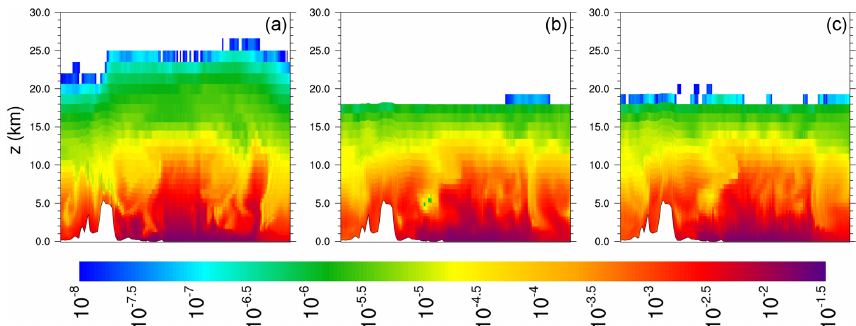
Figure 8. Cross-sectional plots of water vapor mixing ratio (kgkg − 1 ) along longitude 80 ◦ E from 55 ◦ N to 55 ◦ S for 00:00UTC on 31 January 2013 (a) from MPAS-A without FDDA, (b) FDDA target field, and (c) MPAS-A using FDDA at 1 / 10 the strength compared to the other nudged